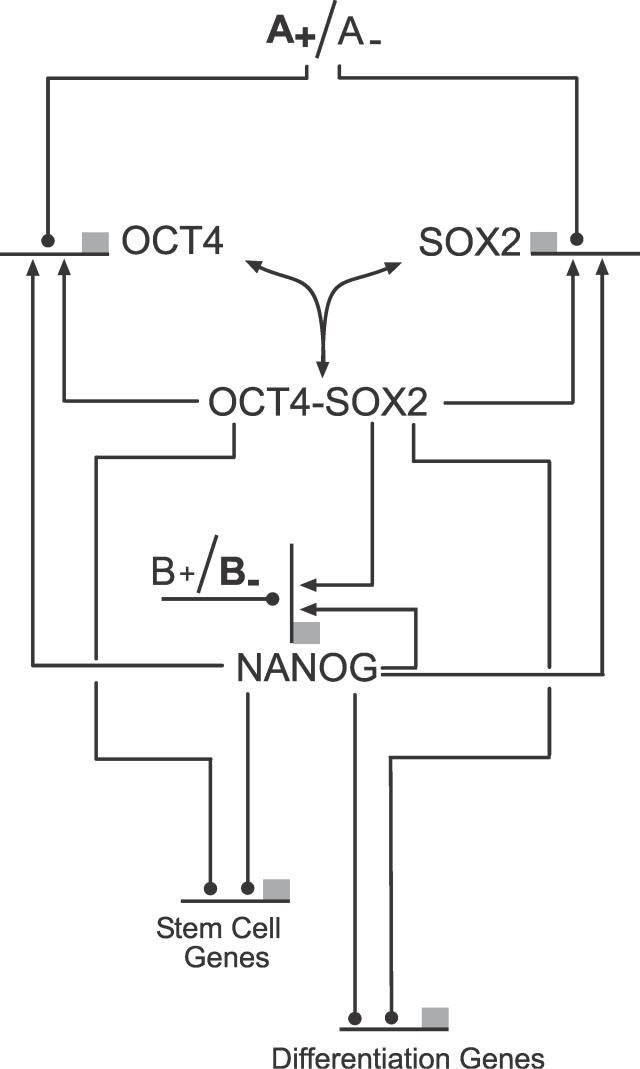
Stoichiometric Map of the Model Corresponding to Figure 1
All protein species are assumed to have a first-order degradation rate. The lines ending with dots could be either activating or repressing, depending on the choice of model.